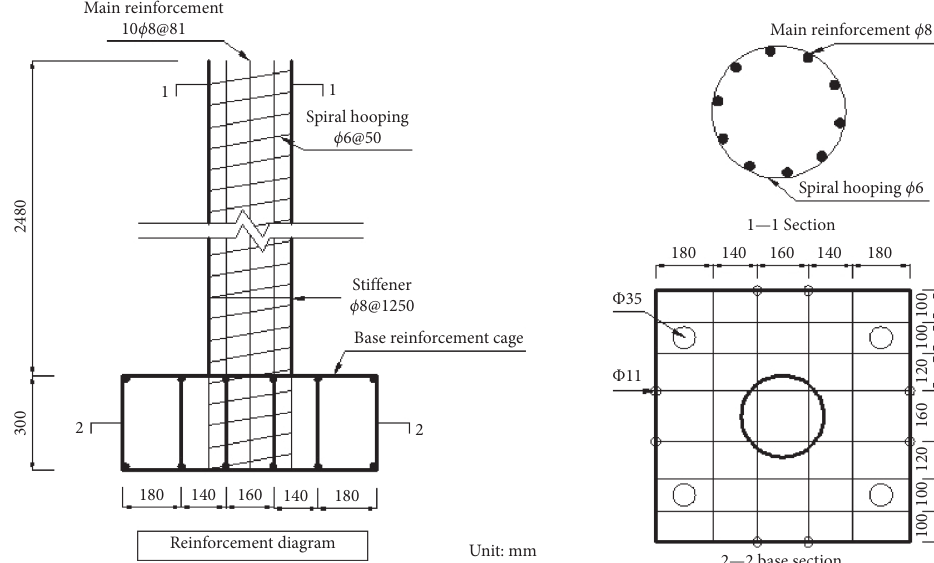
Figure 6: Reinforcement of the model